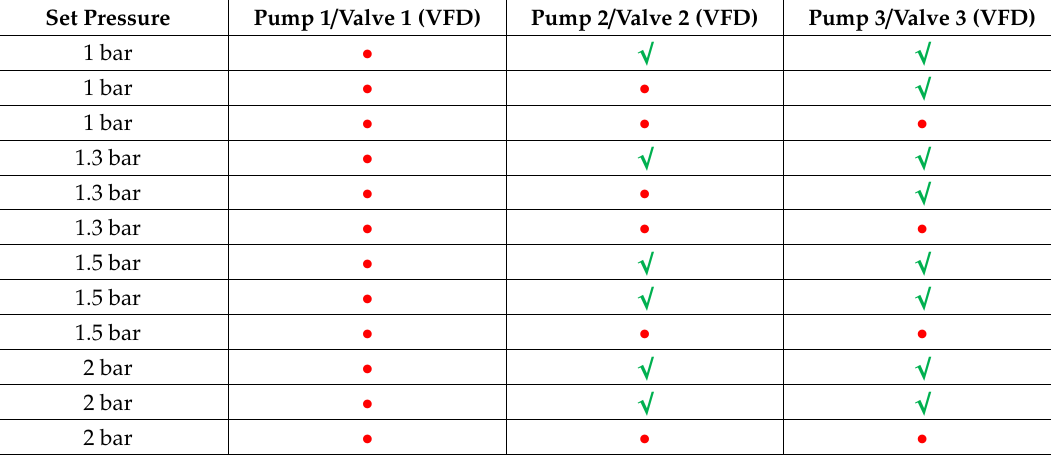
Table 4. Switching states of VFD-based parallel pumping system.